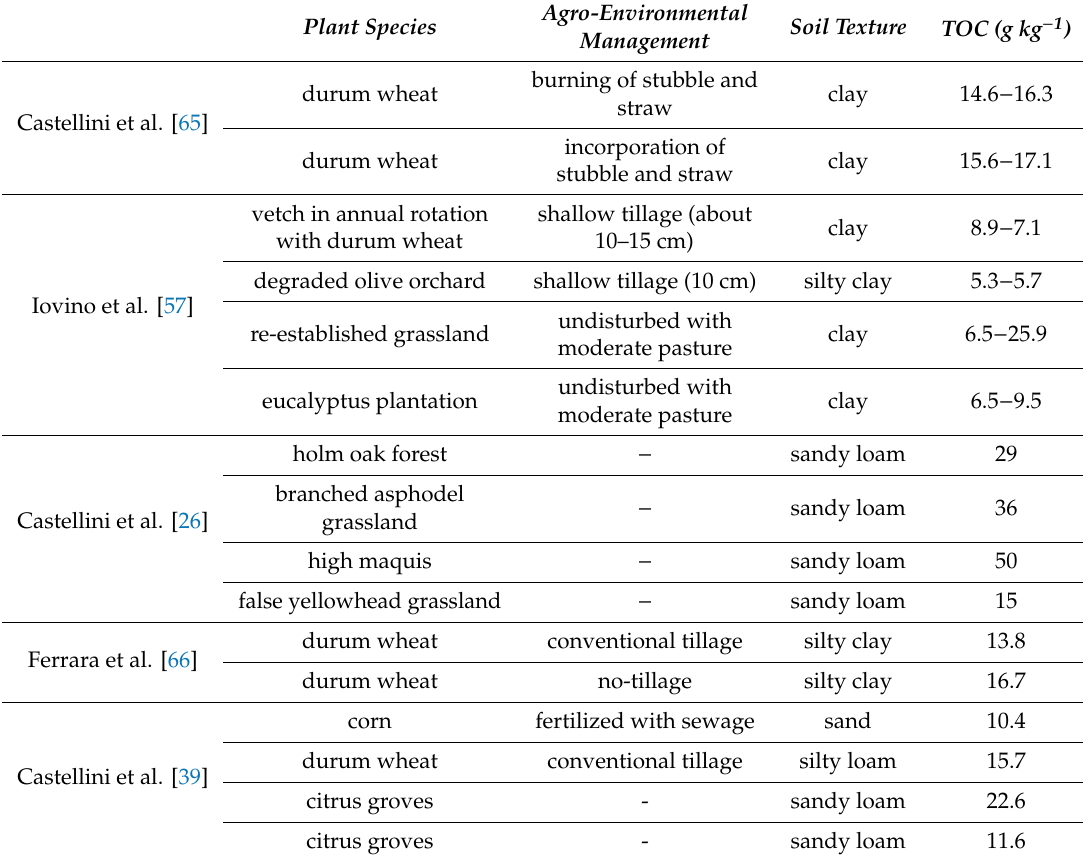
Table 7. Mean values of soil total organic carbon contents ( TOC ) measured for di ff erent types of vegetation, Mediterranean agro-environments and management, and soils textural classes (USDA